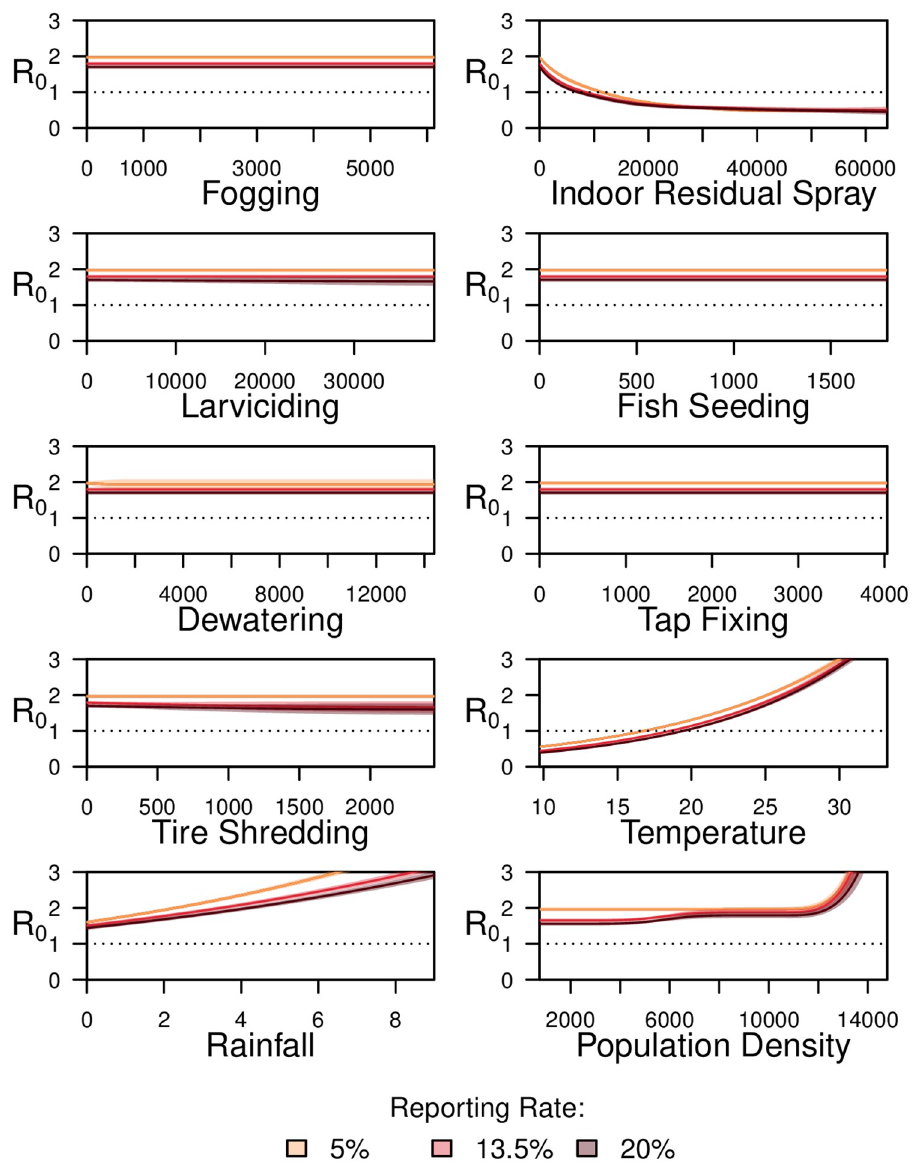
represents the average temperature in Celsius in a lagged time step. For rainfall, x-axis represents the number of rainfall days in a lagged time step. For population density, x-axis represents individuals per 1